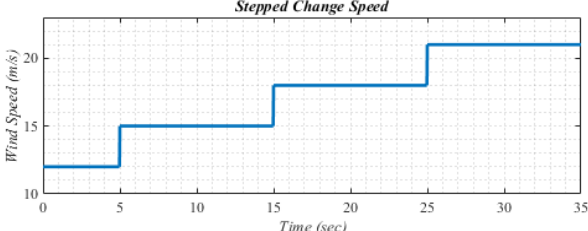
Figure 8. Profile of the multi-step change of wind speed.